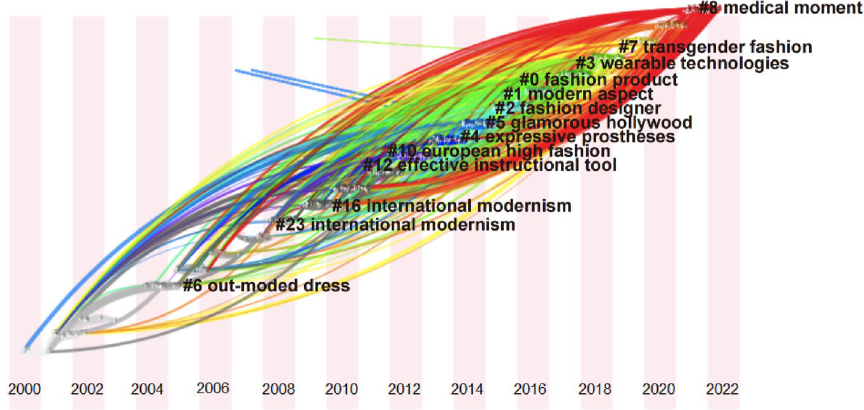
Fig. 8 Time zone view in fashion design